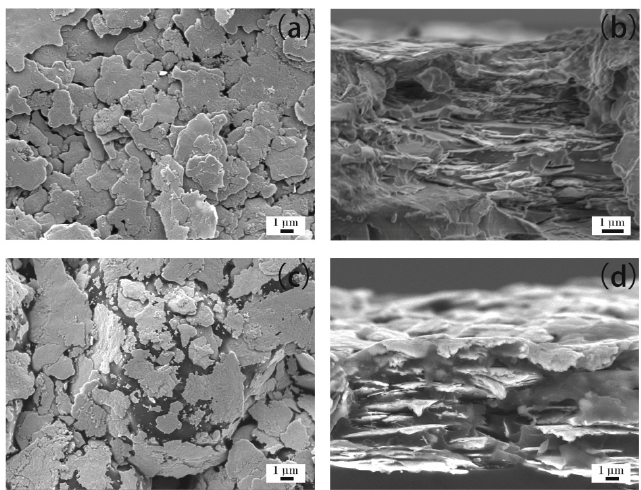
Figure 6. ECAs filled with 40 wt % Ag flakes. ( a ) ECAs fabricated by the powder spraying process; and ( b ) cross sections of ECAs fabricated by the powder spraying process; ( c ) ECAs fabricated by the conventional process; and ( d ) cross sections of ECAs fabricated by the conventional process.